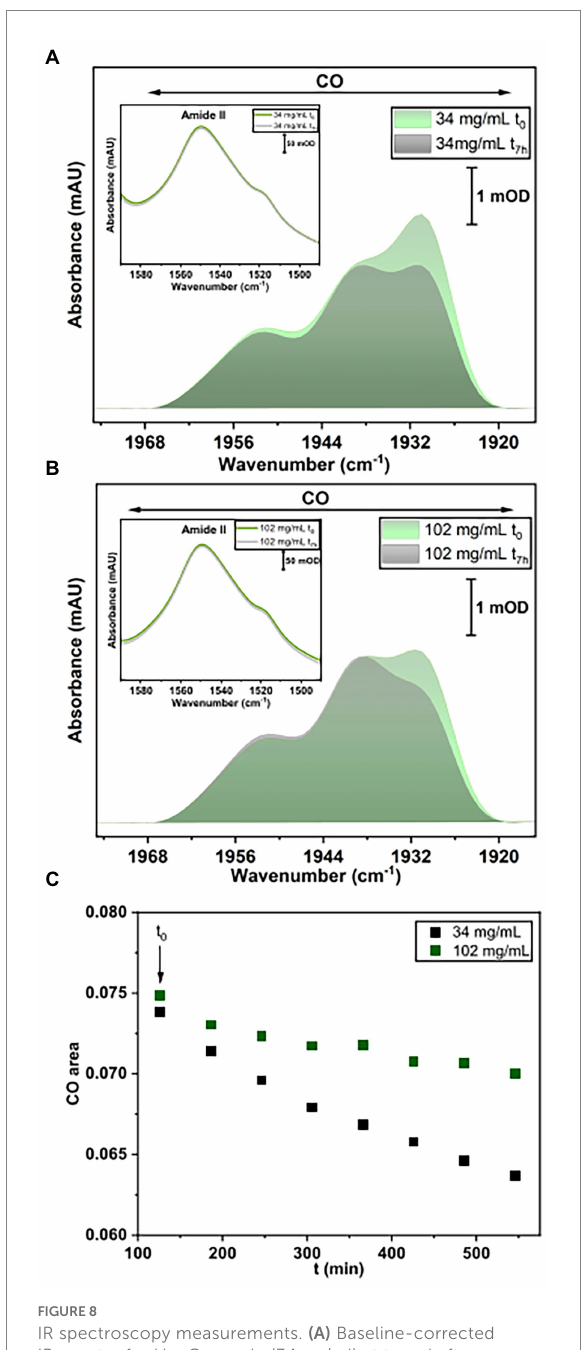
FIGURE 8 IR spectroscopy measurements. (A) Baseline-corrected IR spectra for HoxG sample (34 mg/ml) at t 0 and after 7 h accumulation. (B) Baseline-corrected IR spectra for HoxG sample (102 mg/ml) at t 0 and after 7 h accumulation. The spectral region in (A,B) displays bands related to the CO stretching vibrations of the active site. Shown spectra have been normalized to the intensity of the amide II band (see figure insets in A,B ). (C) Time evolution of the integral of the [NiFe] active site CO absorption bands for the HoxG sample at 30 (black squares) and 100 mg/ml (red squares), respectively. For an adequate comparison of the time evolution of the active site signals in A,B , we have chosen 120 min (t 0 = 120 min) as starting point for plotting the integral intensity of the CO